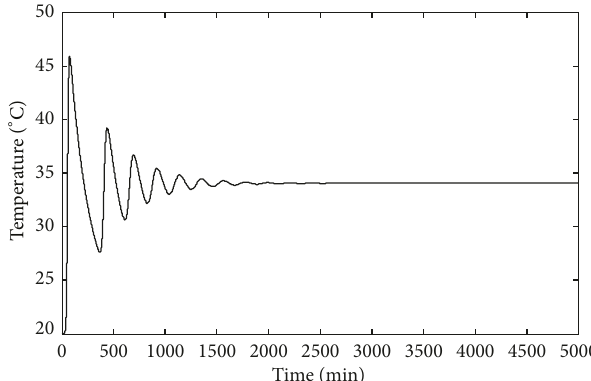
Figure 6: Temperature versus time for thermal hydraulic feedback